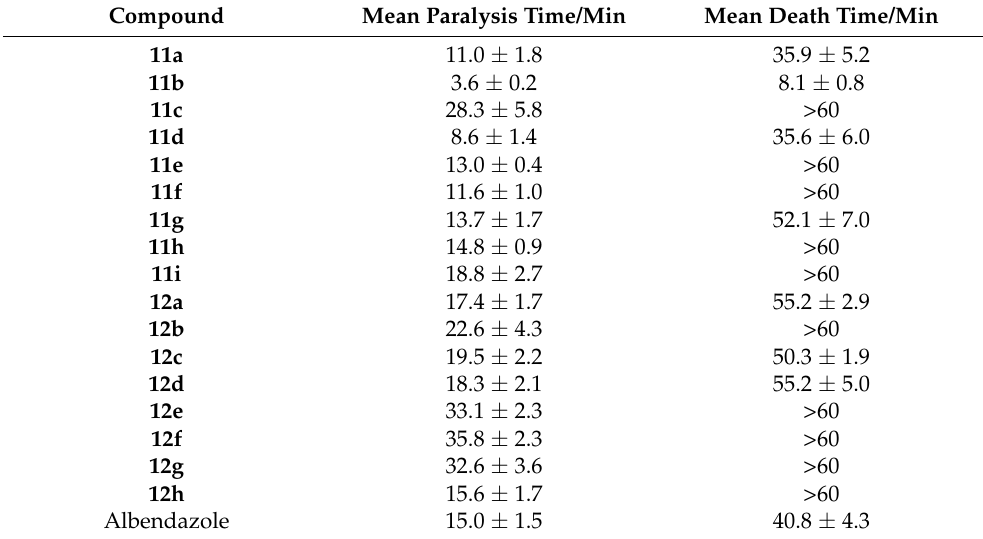
Table 2. Anthelmintic Activities of Target